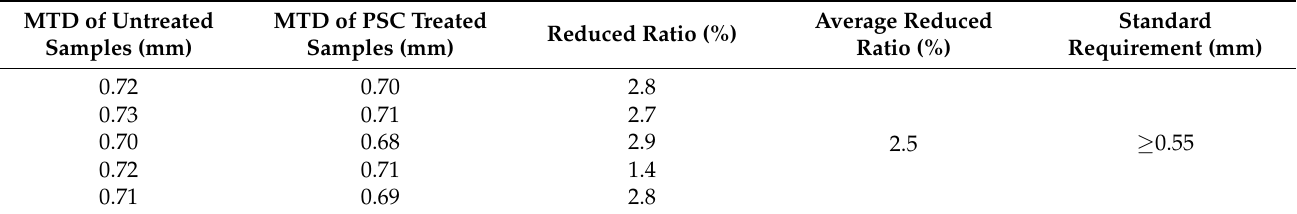
Table 5. Texture depth test